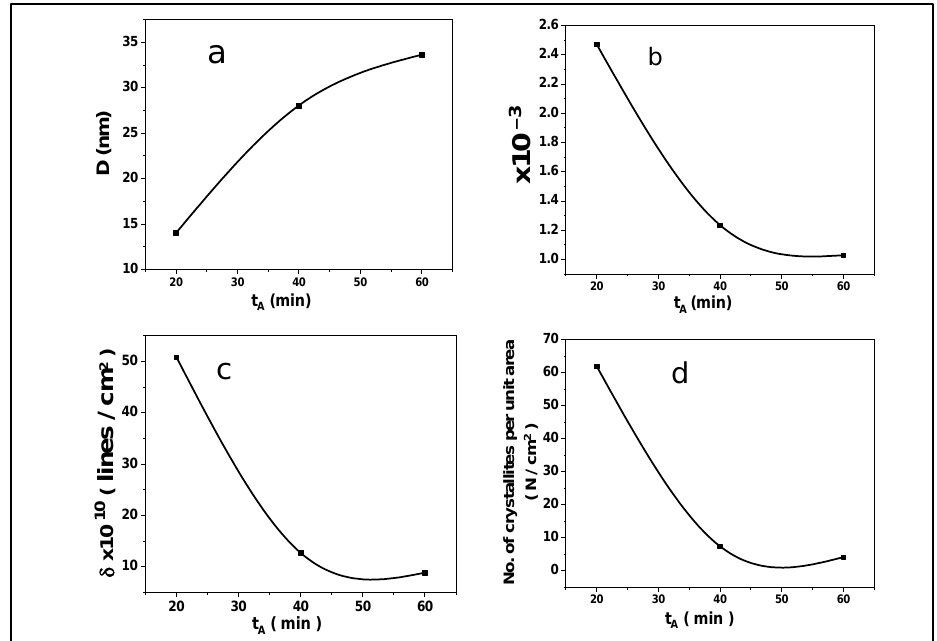
Figure 6. Variation of structural values with annealing time. ( a ) Crystallite size, ( b ) strain, ( c ) dislo- cation density, and ( d ) the number of crystallites per unit area.